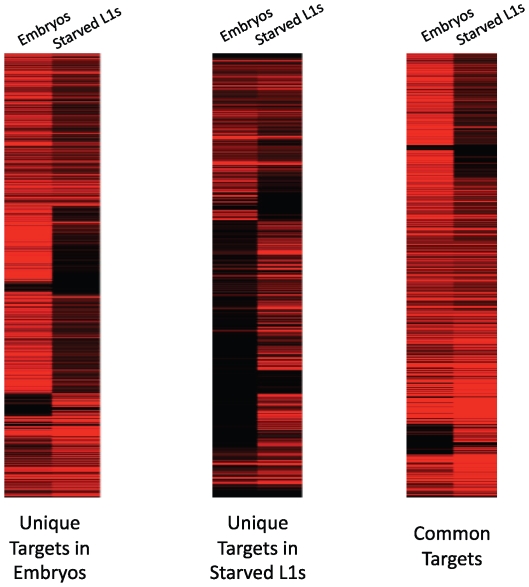
PHA-4 binding correlates with gene expression levels.The expression levels of PHA-4 targets show that binding correlates with increased gene expression. Genes bound by PHA-4 specifically in embryos tend to have higher expression (indicated by increasing red intensity) in embryos than in L1s, whereas genes bound specifically in L1s have higher expression in larvae than in embryos. Genes bound at both stages show a mix of expression levels.